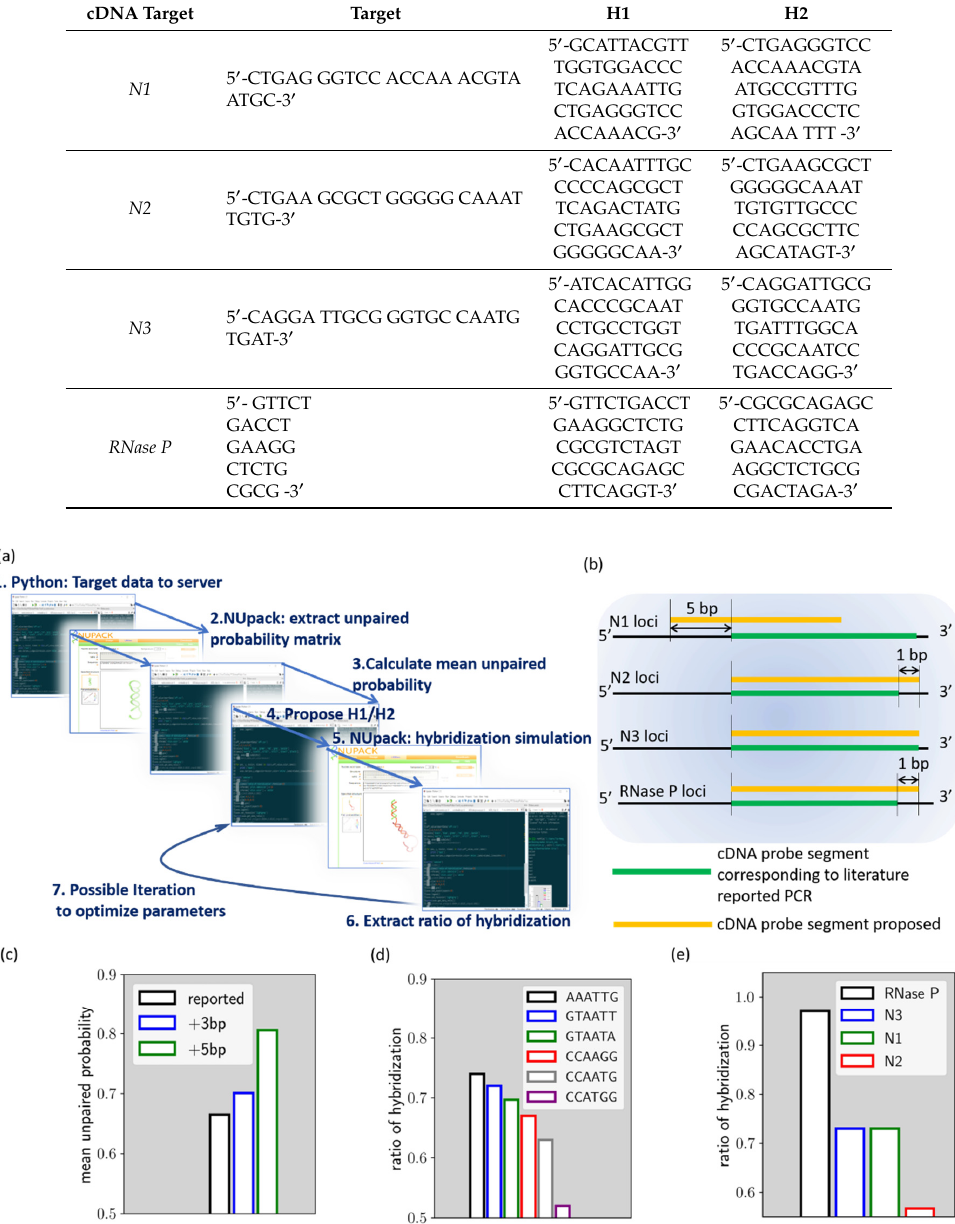
Figure 1. ( a ) Simplified scheme of the proposed HCR designer. ( b ) Comparison between the proposed HCR probe loci and cDNA loci corresponding to the US Center for Disease Control PCR probe. ( c ) mean unpaired probability for target sequence from di ff erent loci of the N1 gene. ( d ) The calculated r h for N1 HCR with di ff erent H1 / H2 loop domains. ( e ) The calculated r h value for all proposed HCR